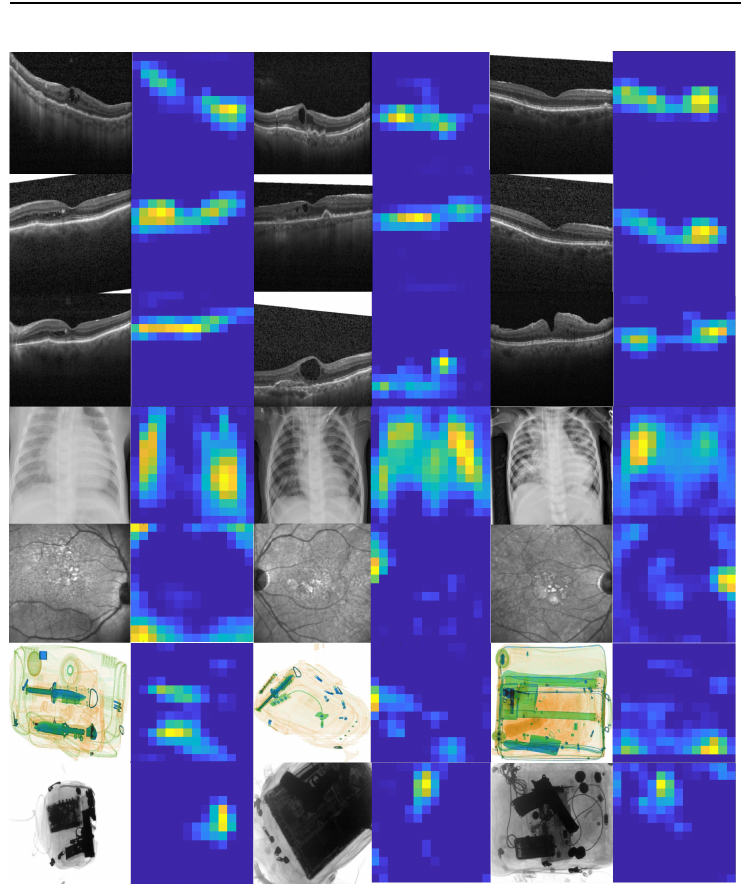
Figure 6. Learned representations on the combined